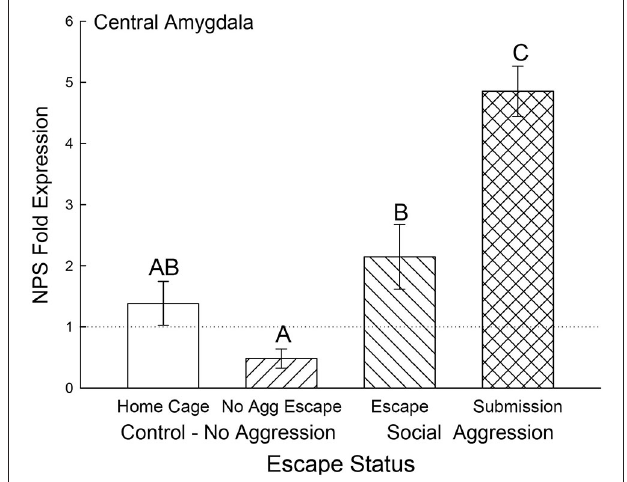
FIGURE 7 | Open field exposure and expectation of submission to social aggression elevate BLA NPS expression . Mean ( ± SEM) fold expression of NPS mRNA in BLA on test day (CS+, US − ) for cage controls (clear bars; N = 11), after SAM exposure in mice not receiving aggression (bars with left hatch; N = 4), after SAM plus social interaction in mice escaping aggression (right hatch; N = 5) and submissive mice (cross hatch; N = 4). Letters above the bar (A, B, C) signify statistical significance ( p < 0.05), such that bars that do not share a common letter (e.g., Escape = A vs. Submission = BC) are significantly different, and those that do share a letter (e.g., No Aggression Escape = C vs. Submission = BC) are not.